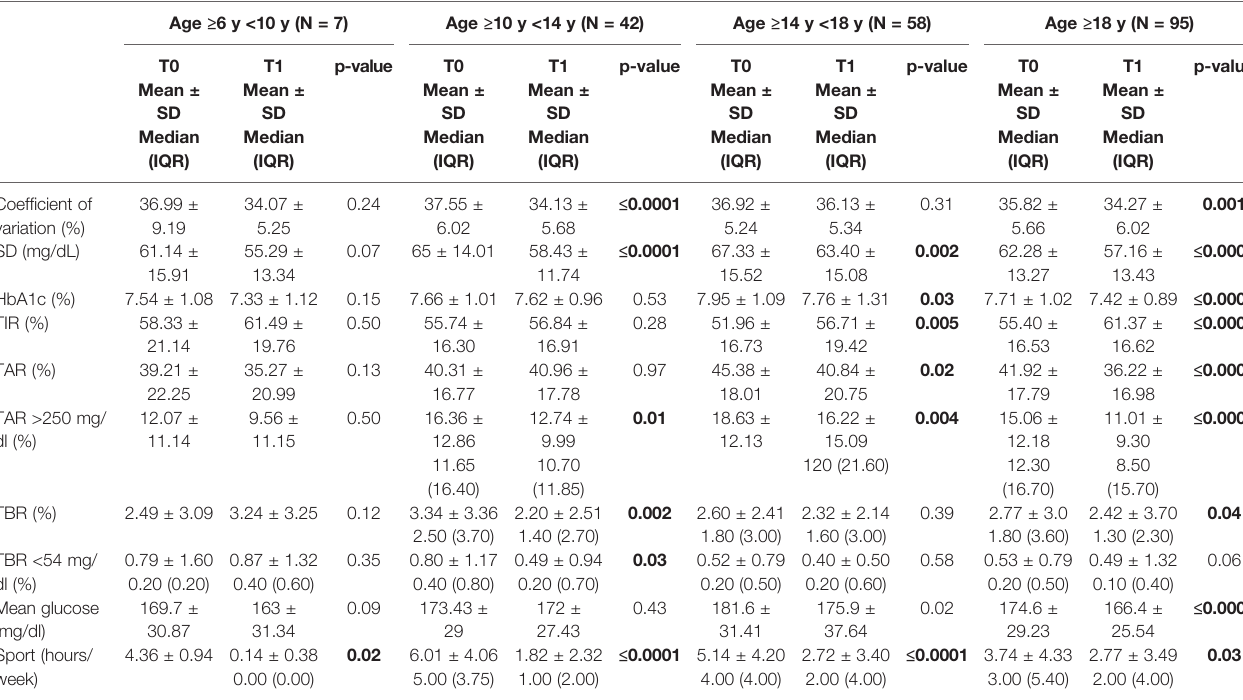
TABLE 3 | Secondary outcome: Glycemic control in relation to age groups at T0 and T1.